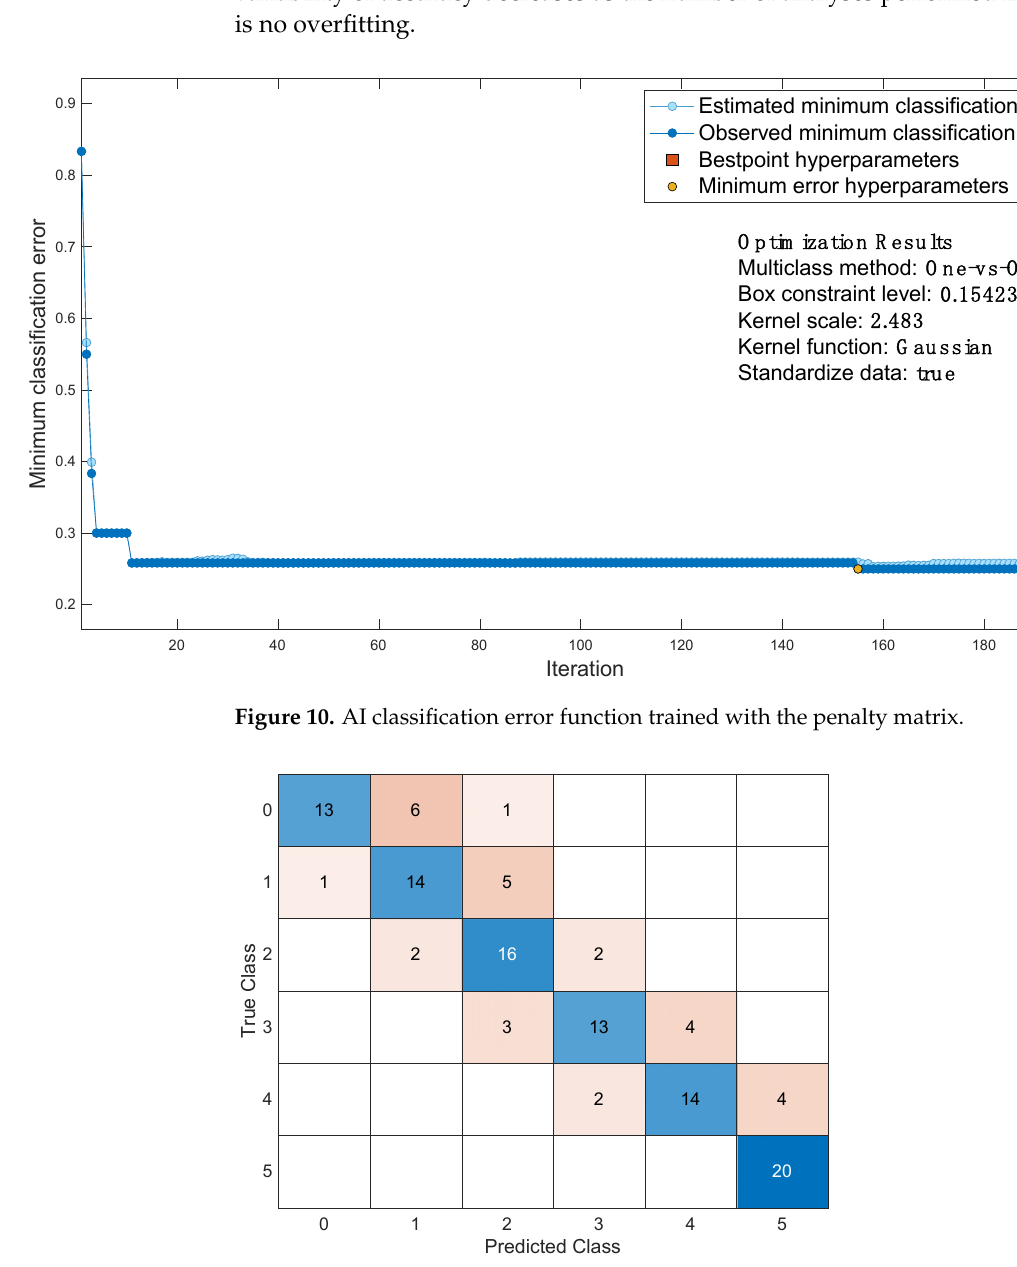
Figure 11. Confusion matrix of AI trained with the penalty matrix.